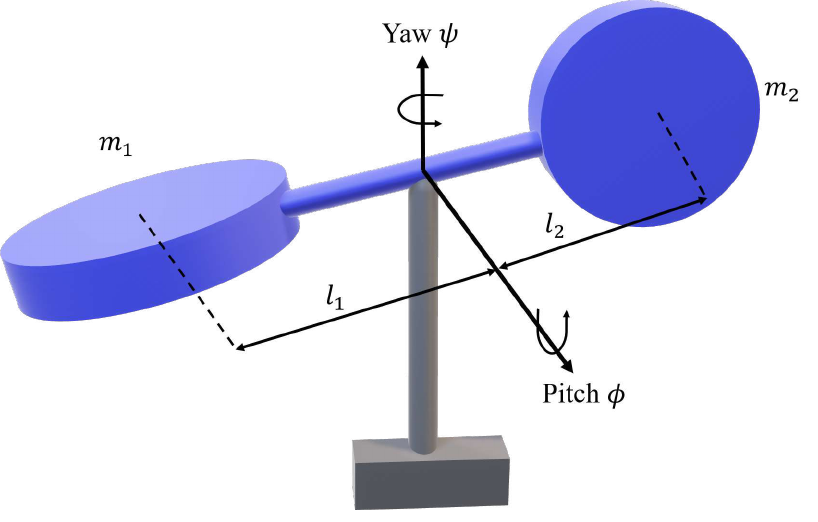
Figure 4. 2-DOF Quanser Helicopter